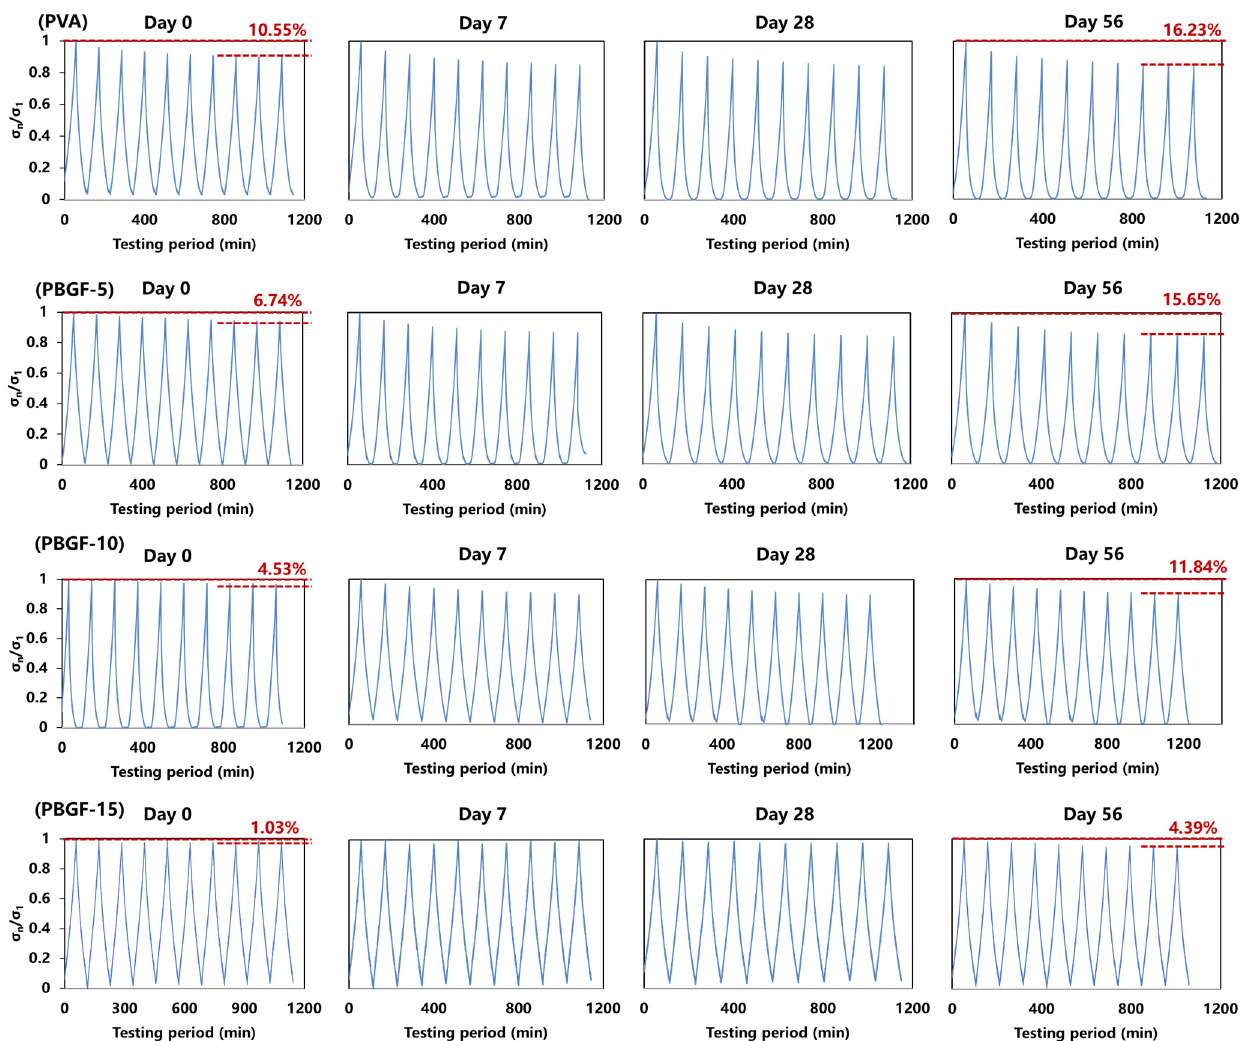
Figure 6. The compressive stress ratio σ n / σ 1 of PVA hydrogel and PBGF composites as a function of time under 10 cycles when immersed in PBS for 56 days.